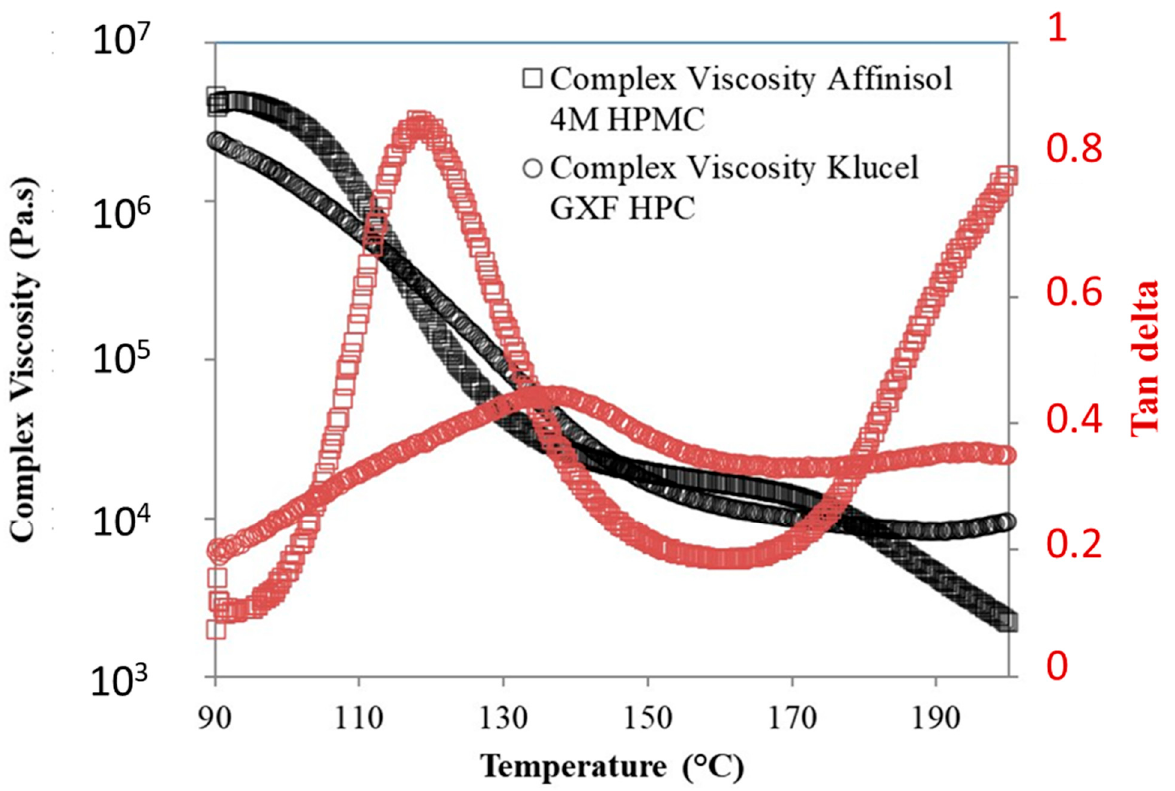
Figure 5. Temperature sweep (complex viscosity and Tan delta as a function of temperature) of HPMC HME 4M and HPC GXF using parallel plate rheometer. Both HPMC HME 4M and HPC GXF show decreases in the complex viscosity as the increase in the temperature.